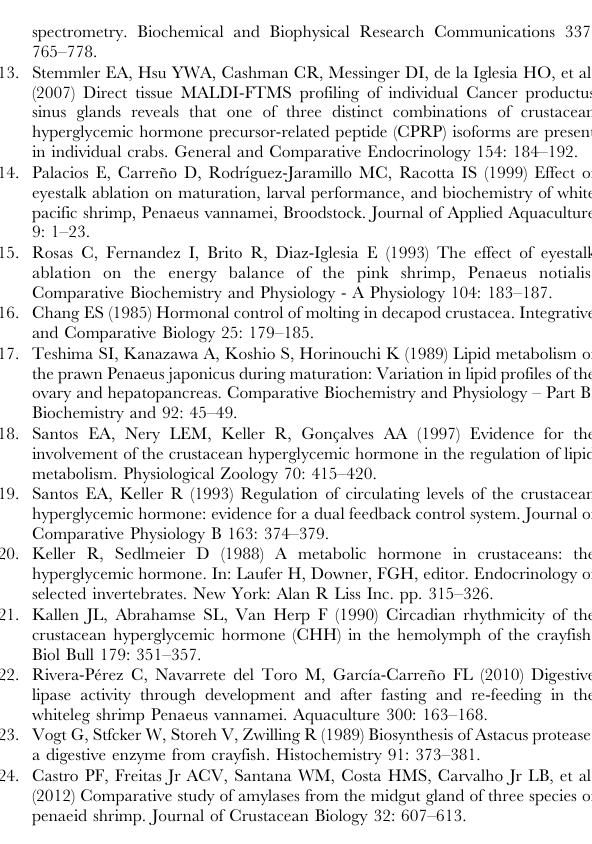
Figure S1 The distribution of BLAST 13 Top Hit Species matching P. leptodactylus contigs. (TIF) Figure S2 Clustering the 12 mapping profiles of individual females using hierarchical and principal component analyses. A : Hierarchical clustering applying three clustering protocols, complete and single linkages and group average. (S) – sham injected, (N) – intact, (L) – L-cHH-injected, (D) – D-cHH-injected. B : principal component analysis. Green – native, Red – sham, Blue – L-cHH-injected and Yellow – D-cHH-injected.